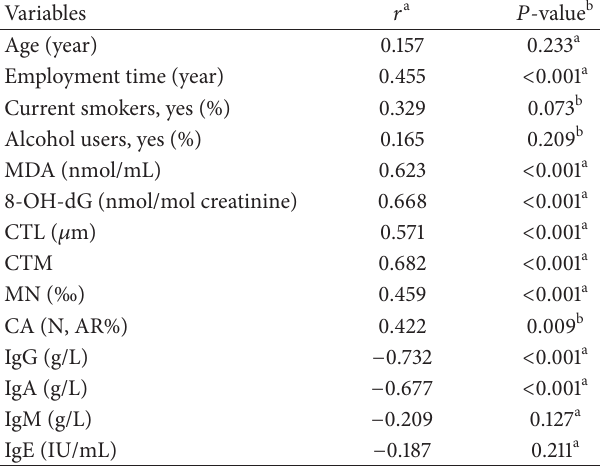
Table 4: Correlations of 1-OHP levels and the other studied variables in total subjects.